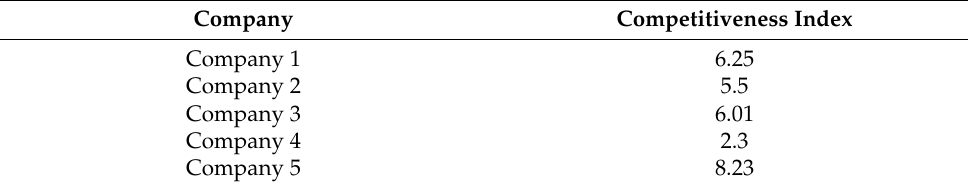
Table 3. Competitiveness index affiliated with each construction company.